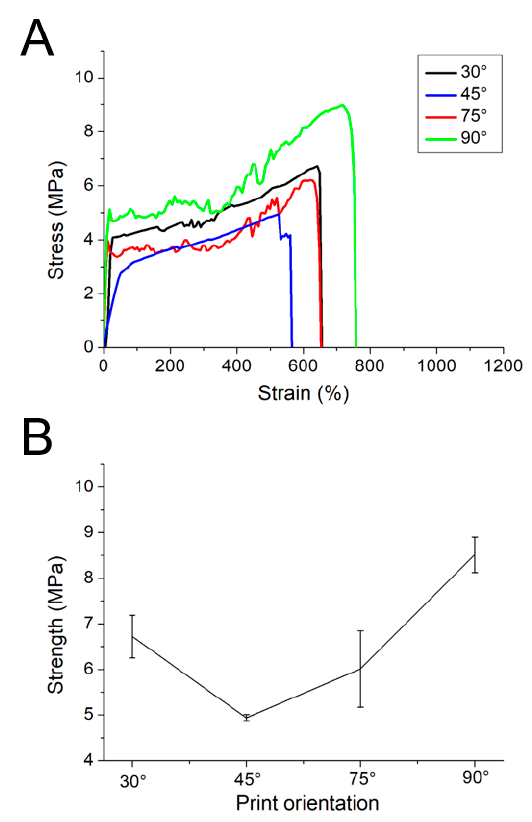
Figure 8. Effect of print orientation of infill on the mechanical properties of additively manufactured PCL parts (A: stress strain curves; B: maximum tensile strengths, other parameters used were those of Level 2 in Table 1).